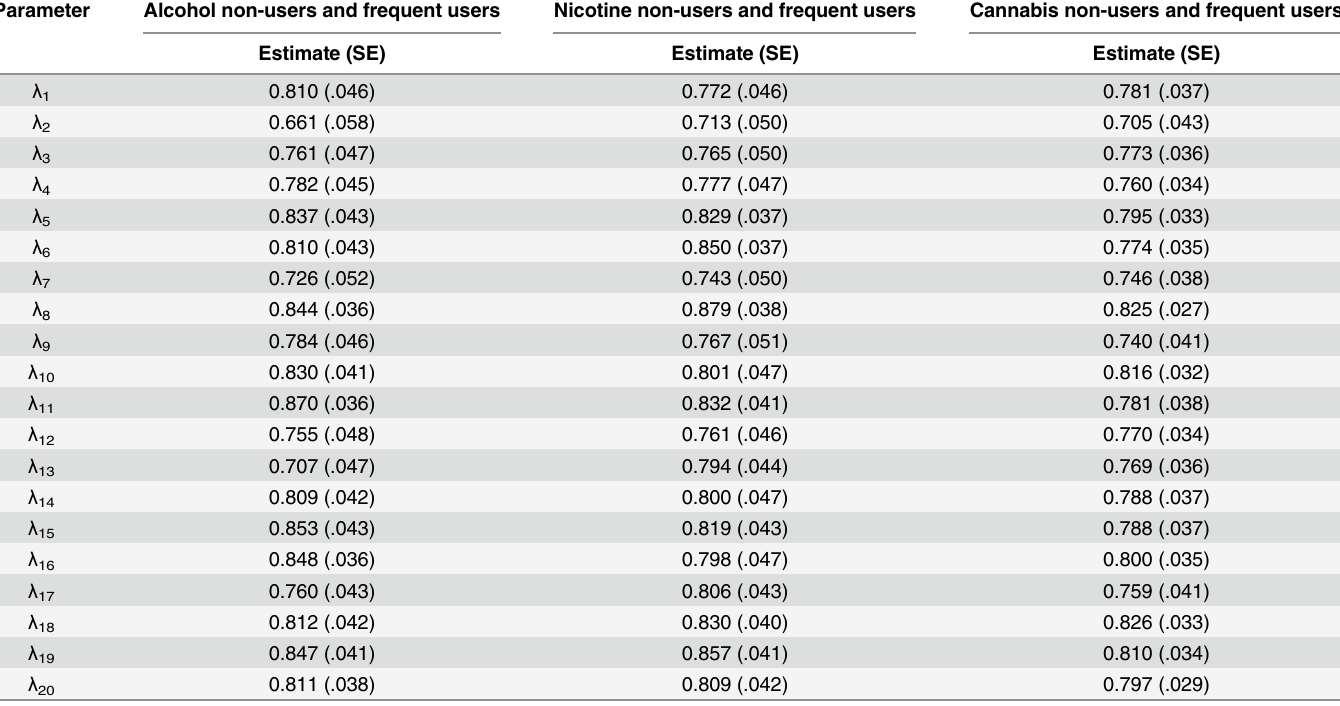
Table 4. Factor loading ( λ ) estimates for Beck Depression Inventory items for non-users and frequent-users of alcohol, nicotine, and cannabis, under the factorial invariance